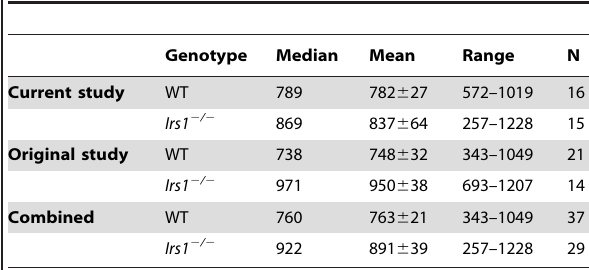
Table 1. Comparative survival characteristics of female wild type (WT) and Irs1 2 / 2 mice.